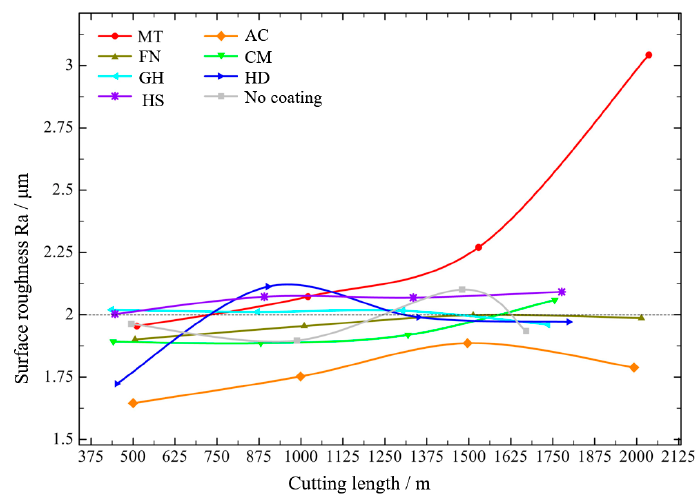
Figure 13. Surface roughness of the workpiece of different coatings at low speed.